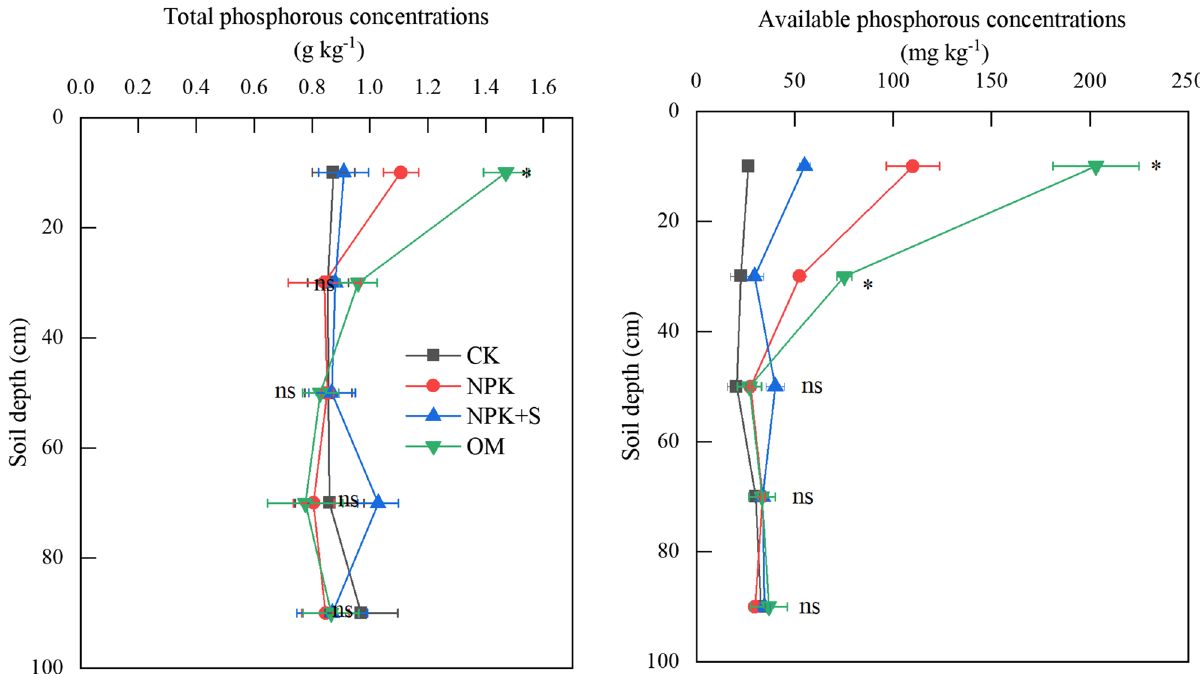
Figure 2. Effect of long-term application of chemical fertilizer, organic manure, and straw on total phosphorus (P) and available P concentrations. * indicates significant difference at P < 0.05 level at same soil depth, ns indicates no significant difference between the total phosphorus (P) and available P concentrations at the same soil depth. CK, no fertilizer application; NPK, chemical fertilizer application; NPK + S, chemical fertilizer plus maize straw incorporation; OM, organic manure application.